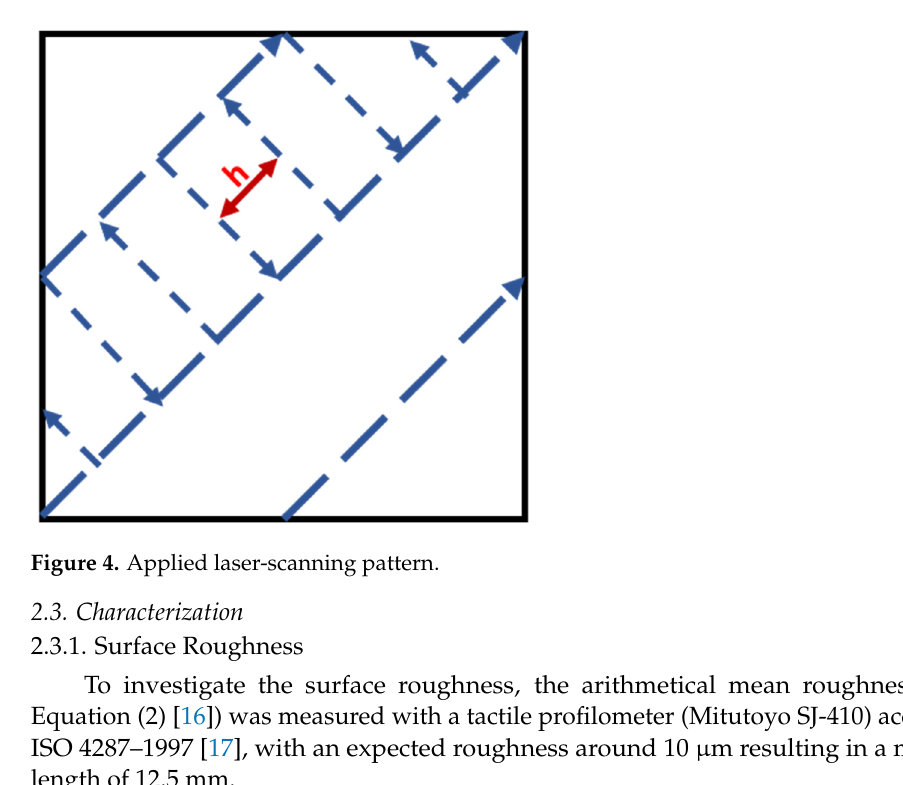
Figure 3. Component layout on base plate.